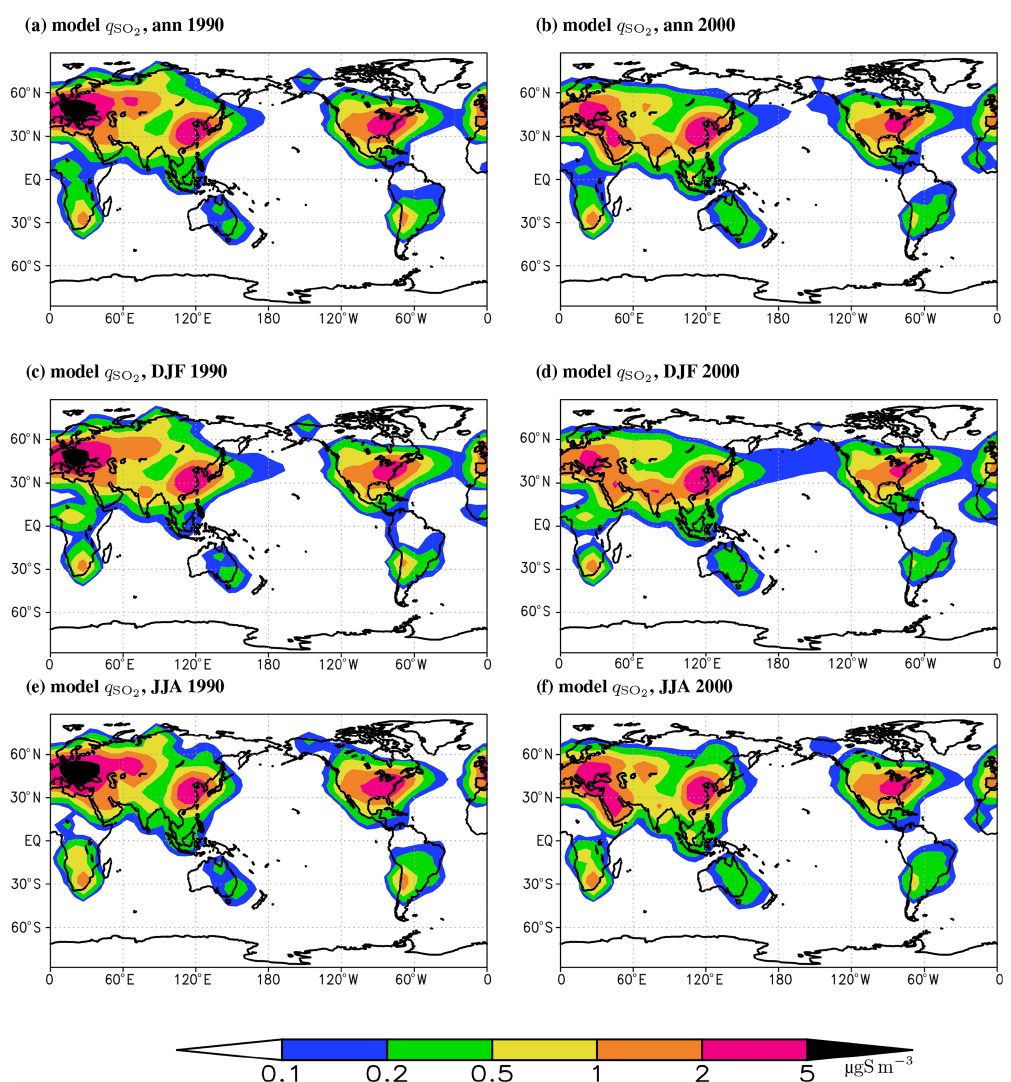
Figure 4. The modelled near-surface concentration of sulfur dioxide in 1990 (a, c, e) and 2000 (b, d, f) . The top, middle, and bottom rows show annual means, the average for boreal winter, and the average for boreal summer,